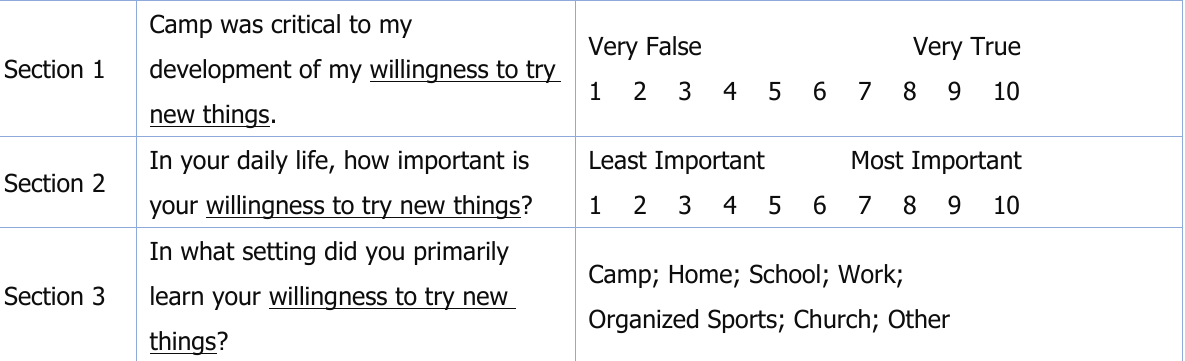
Table 2. Sample Items From Survey